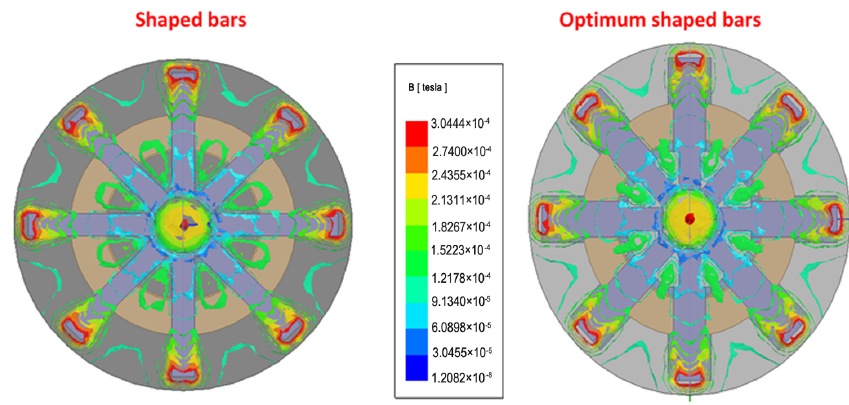
Figure 17. Electromagnetic field distribution on the receiving aluminium pates for shaped bars and optimum shaped bars.